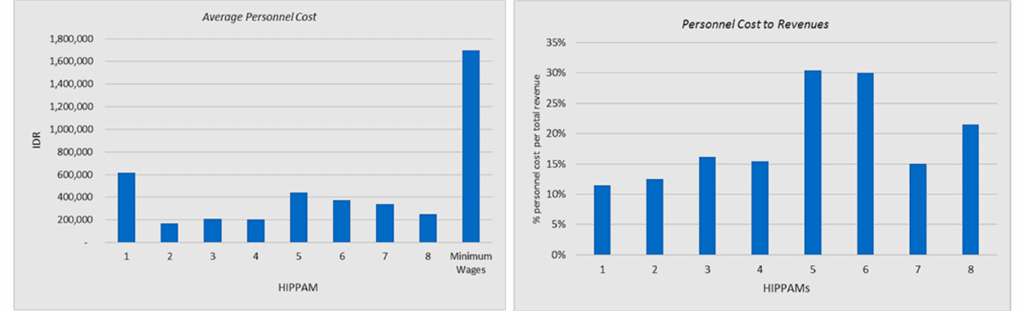
Figure 1. Personnel Cost and Personnel Cost as a Percentage of Revenues